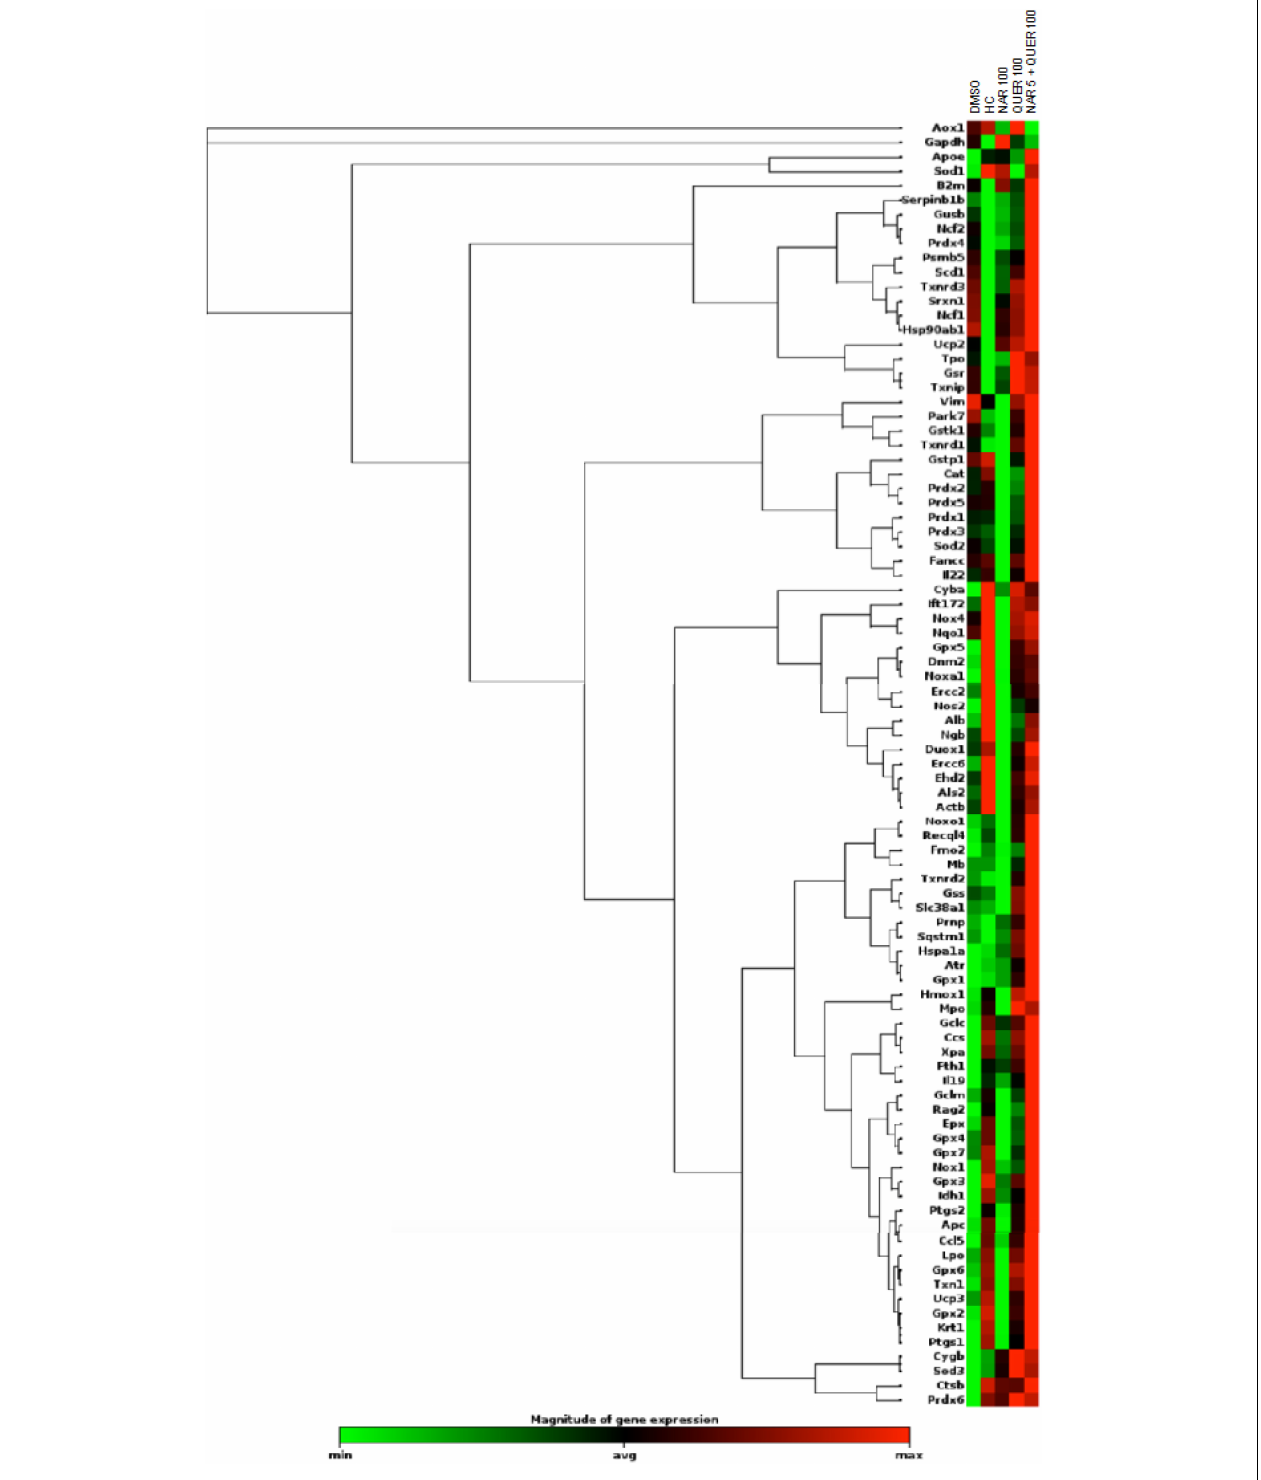
FIGURE 6 | Heatmap of genes (mRNAs) involved in oxidative stress and antioxidant response. Columns reports the transcriptional expression levels of 84 genes in groups treated with DMSO alone (control group), naringenin 100 mg/kg/day, quercetin 100 mg/kg/day, and naringenin 50 + quercetin 100 mg/kg/day ( n = 6, respectively). Furthermore, the expression levels of the same genes in HC ( n = 6). Each square represents the mean values of the values obtained after normalization on the mean expression of the most stable genes among those analyzed. Red color indicates the most upregulated expression levels, while green color indicates the least downregulated expression